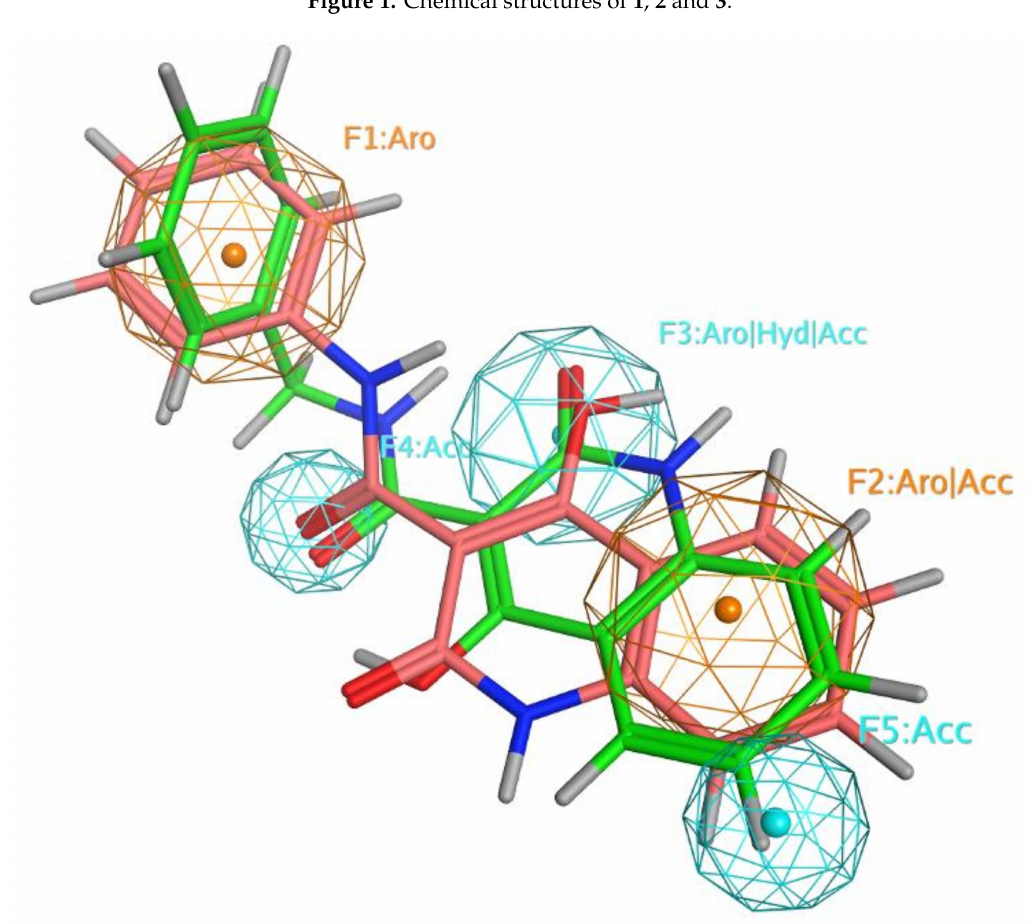
Figure 2. PI3K α inhibitor pharmacophore model with ( 1 ) and ( 2 ) depicted in green and orange color, respectively. Picture made by MOE